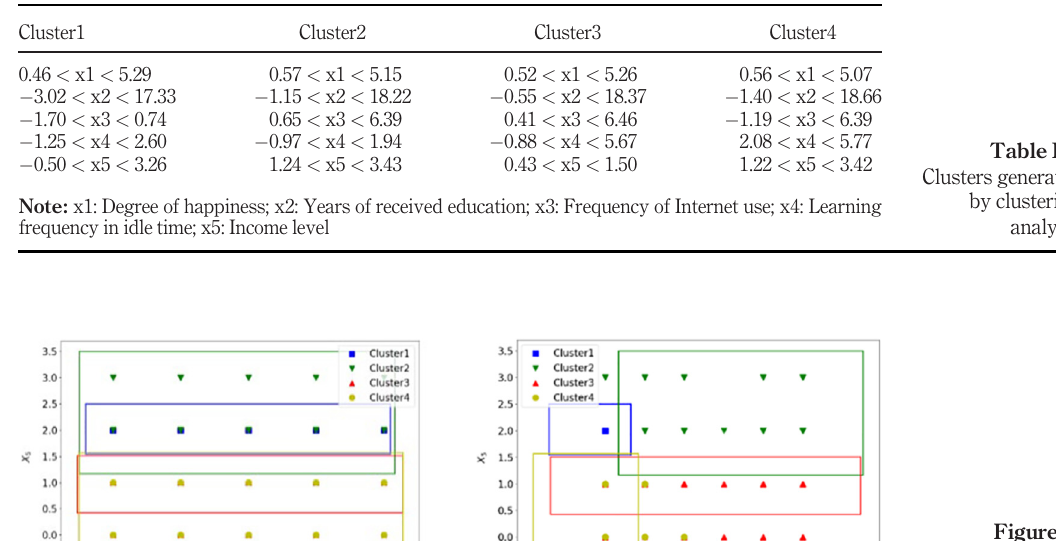
Figure 5. The visualization